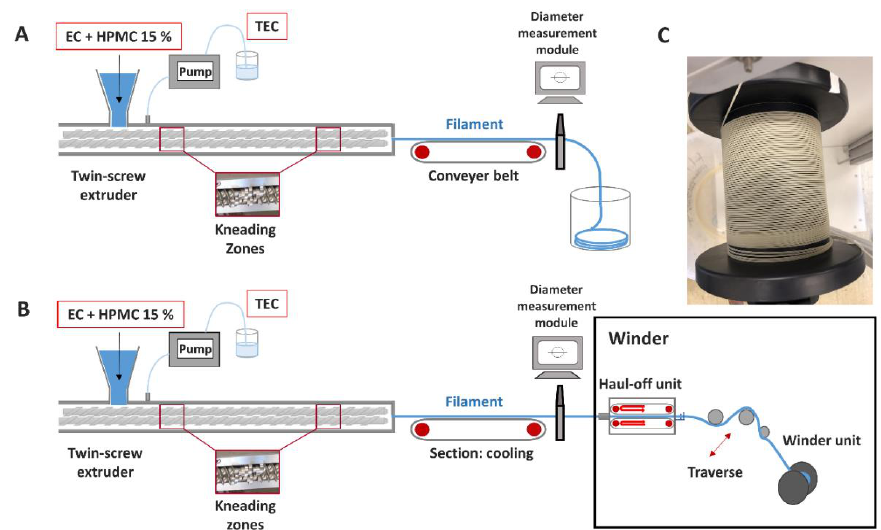
Figure 1. HME setup for filament production before ( A ) and after ( B ) optimization by implementing a winder. Subfigure ( C ) displays an exemplary winding process in the winder unit.